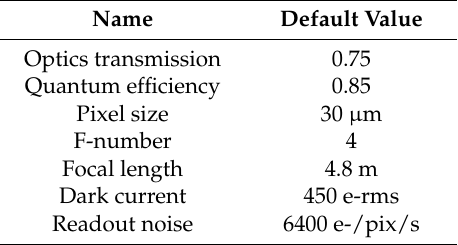
Table 2. List of parameters used to calculate signal-to-noise ratio (SNR) for simulation.